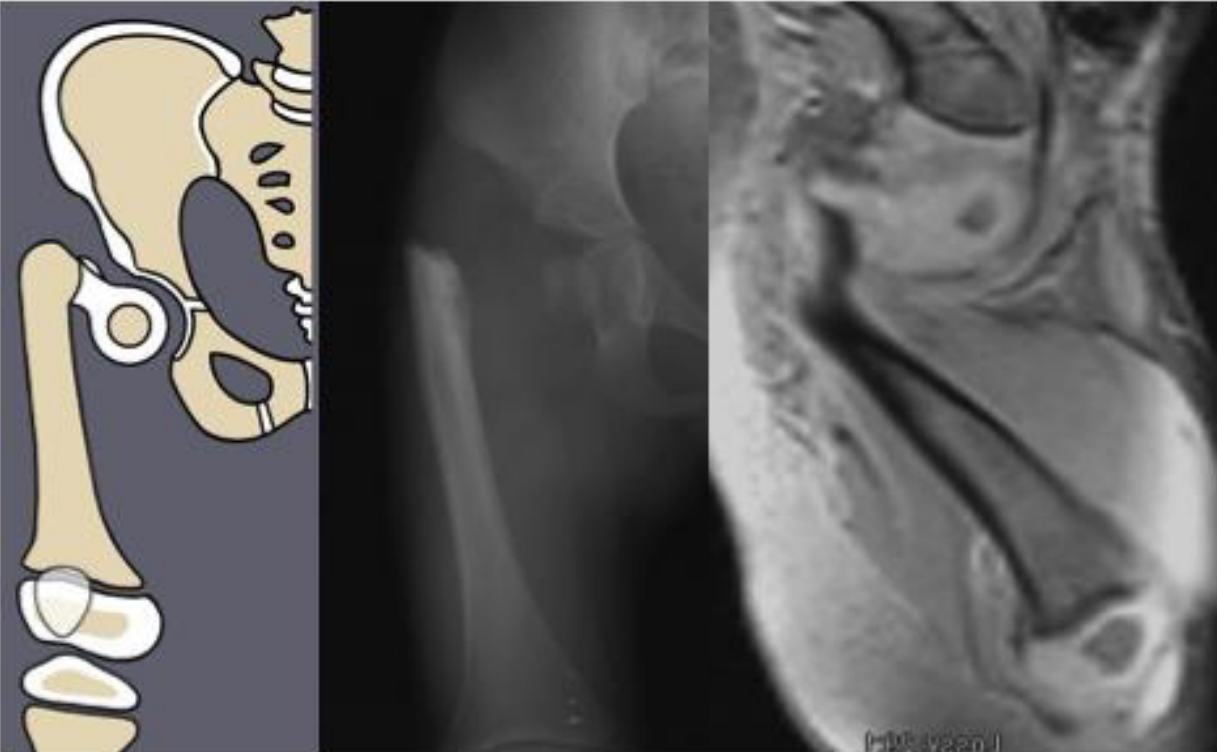
Figure 2. Paley type 1b 2 (neck type) CFD example. Illustration (left), radiograph showing delayed ossification of femoral neck (center), and MRI showing cartilaginous neck (right).